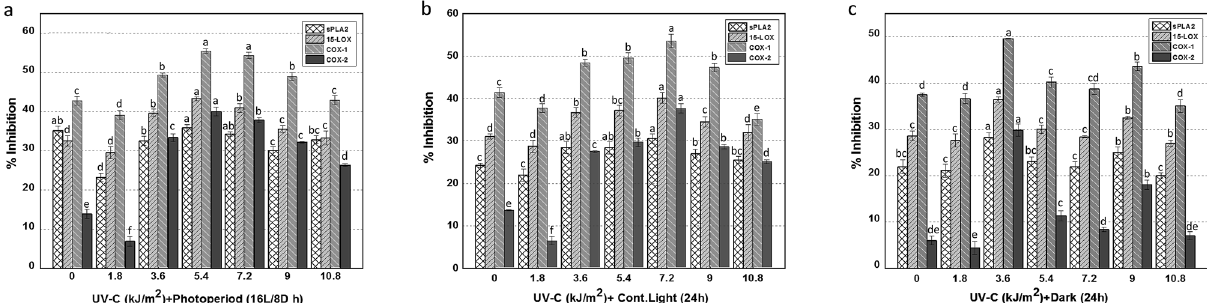
Figure 7. ( a ) Anti-inflammatory activities of callus cultures of Fagonia indica elicited with UV-C radiations (0–10.8 kJ/m 2 ) and grown in photoperiod (16L/8D h) using sPLA2, 15-LOX, COX-1 and COX-2 cell free in vitro assays. The activities of extracts were expressed as % inhibition. ( b ) Anti-inflammatory activities of callus cultures of Fagonia indica elicited with UV-C radiations (0–10.8 kJ/m 2 ) and grown in cont. light (24 h) using sPLA2, 15-LOX, COX-1 and COX-2 cell free in vitro assays. The activities of extracts were expressed as % inhibition. ( c ) Anti-inflammatory activities of callus cultures of Fagonia indica elicited with UV-C radiations (0–10.8 kJ/m 2 ) and grown in complete dark (24 h) using sPLA2, 15-LOX, COX-1 and COX-2 cell free in vitro assays. The activities of extracts were expressed as % inhibition. Employed under the same experimental conditions as sample extracts, reference inhibitors were used as positive controls: Ibuprofen (10 µM) was used as positive control for COX-1 and COX-2 activity leading to enzyme inhibition of 31.4 ± 0.8% and 29.8 ± 1.2%, respectively; Thioetheramide-PC (5 µM) was used as sPLA2 inhibitor, resulting in an inhibition of 43.7 ± 0.8%; Nordihydroguaiaretic acid (100 µM) was used as 15-LOX inhibitor, leading to an inhibition of 30.6 ± 0.7%. The same volume of extraction solvent was used as blank. Values represented as mean ± SE of three